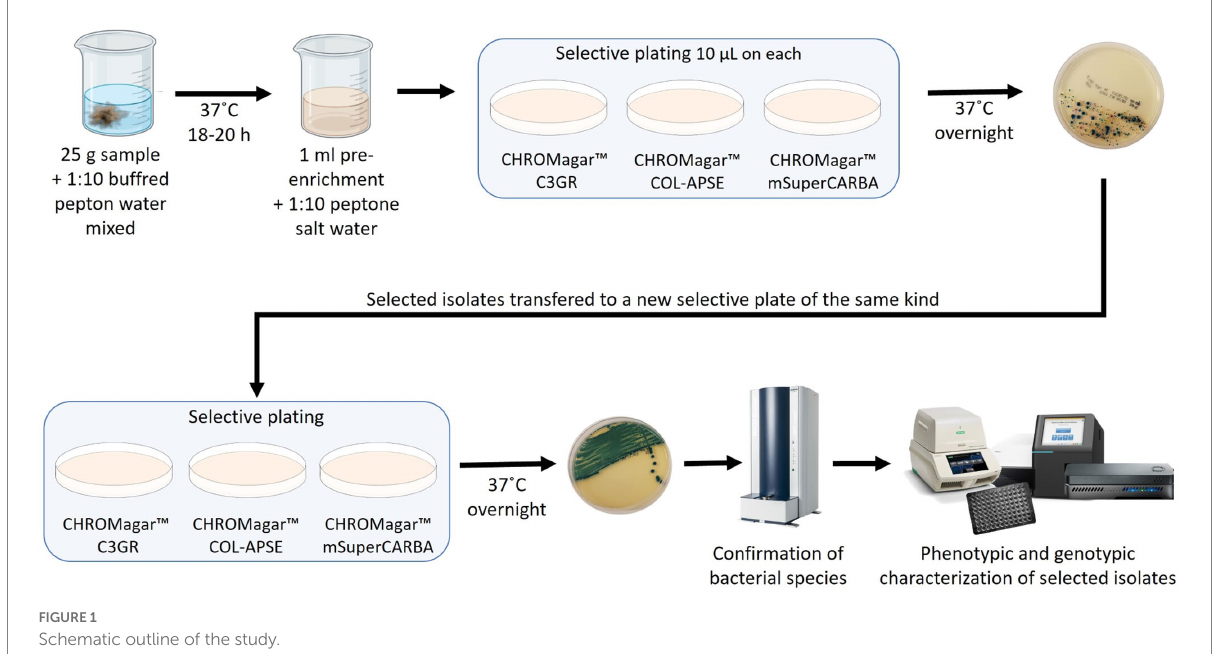
FIGURE 1 Schematic outline of the